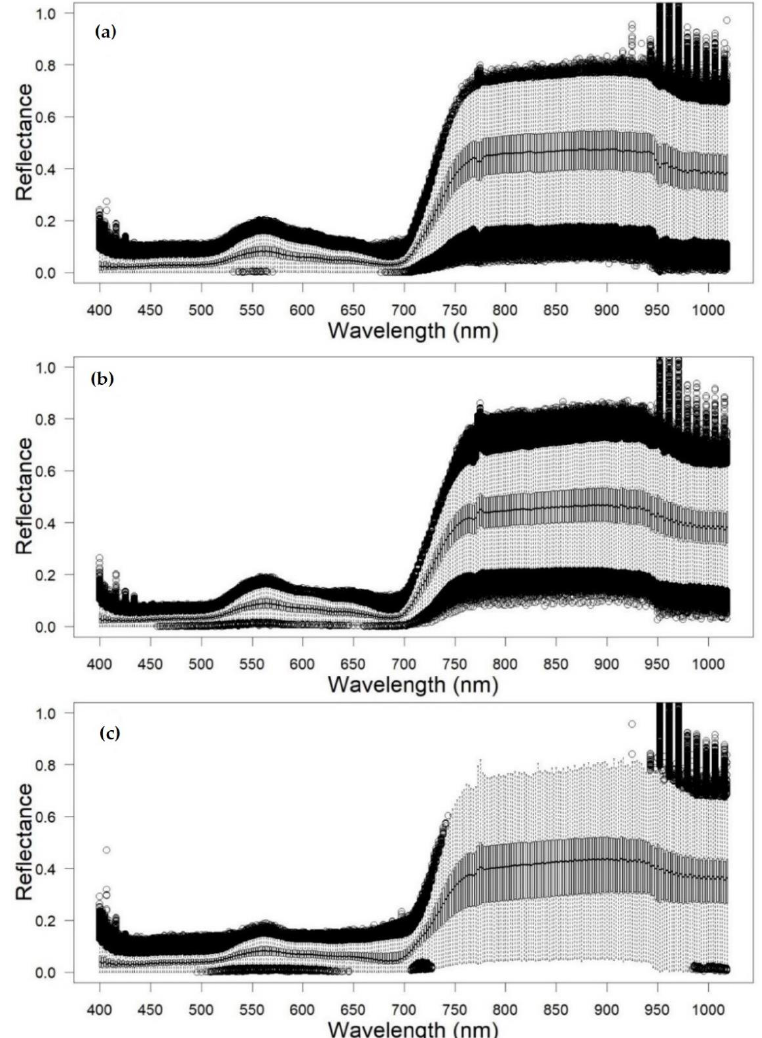
Figure 5. A boxplot visualization of the spectral signatures extracted from the three classes: healthy tree ( a ), fresh damage ( b ), and old damage ( c ). The minimum quartile (0th percentile), the maximum quartile (100th percentile), the first quartile (25th percentile), and the third quartile (75th percentile), and the median (50th percentile) are shown as well as outliers (circles) for each class at each hyperspectral band.